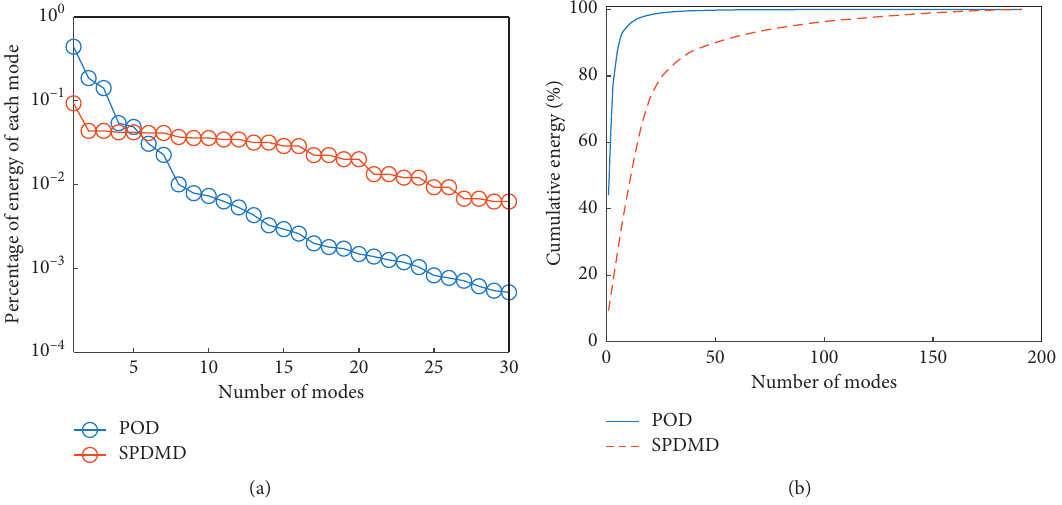
Figure 2: (a) Percentage of the energy of each mode (b) and cumulative energy distribution of the 200hPa